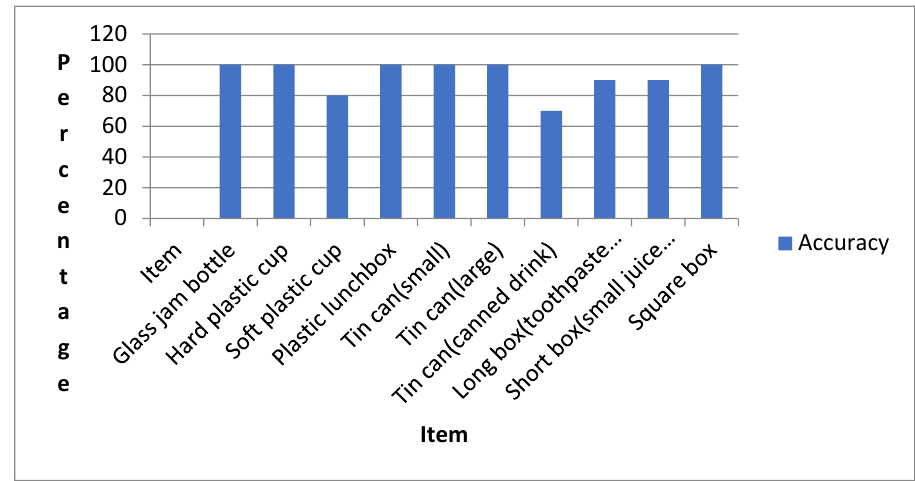
Figure 25. Classification test accuracy of the recyclable items.